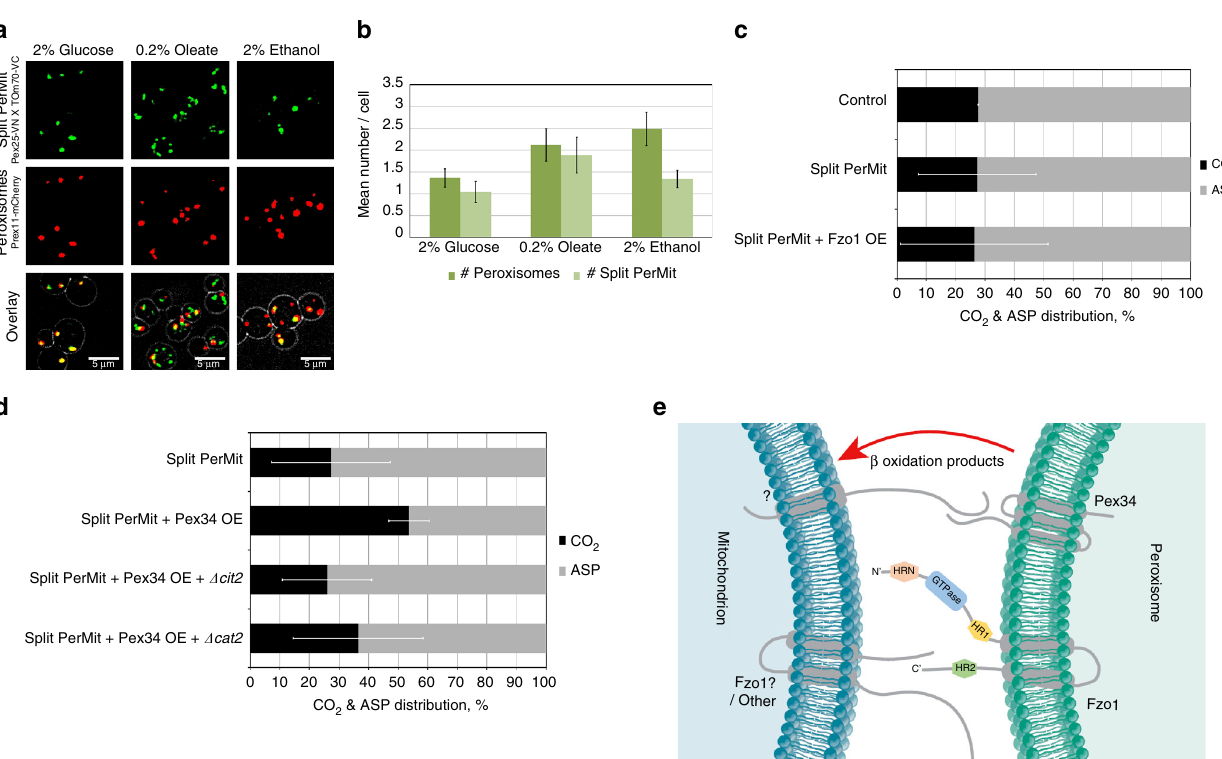
Fig. 5 The PerMit contact site contributes to β -oxidation. a Cells expressing the PerMit reporter and a peroxisomal marker (Pex11-mCherry) were grown in media containing either glucose, oleate, or ethanol as a sole carbon source. Representative images in different media are shown. b Quanti fi cation of the number of Pex11-mCherry and PerMit reporter puncta per cell showing that the number of PerMit contacts relative to the number of peroxisomes is increased in oleate. Data are presented as mean ± s.d. from four independent experiments, 100 cells per experiment. c , d Strains were grown on oleate and were assayed for β -oxidation activity. The CO 2 production and the acid soluble products (ASPs) were used to quantify fatty acid oxidation. Results are presented as percentage relative activity to the rate of oxidation in a control strain. Data are presented as mean ± s.d. from three or more independent experiments. e A schematic hypothesis model of the new fi ndings regarding the PerMit contact site. Pex34 should interact with an unknown mitochondrial protein (marked by “ ? ” ) to mediate the contact site and to potentially enable metabolite transfer of β -oxidation products. Fzo1 on mitochondria may mediate tethering either by interacting with the peroxisomal pool of Fzo1 or with another peroxisomal